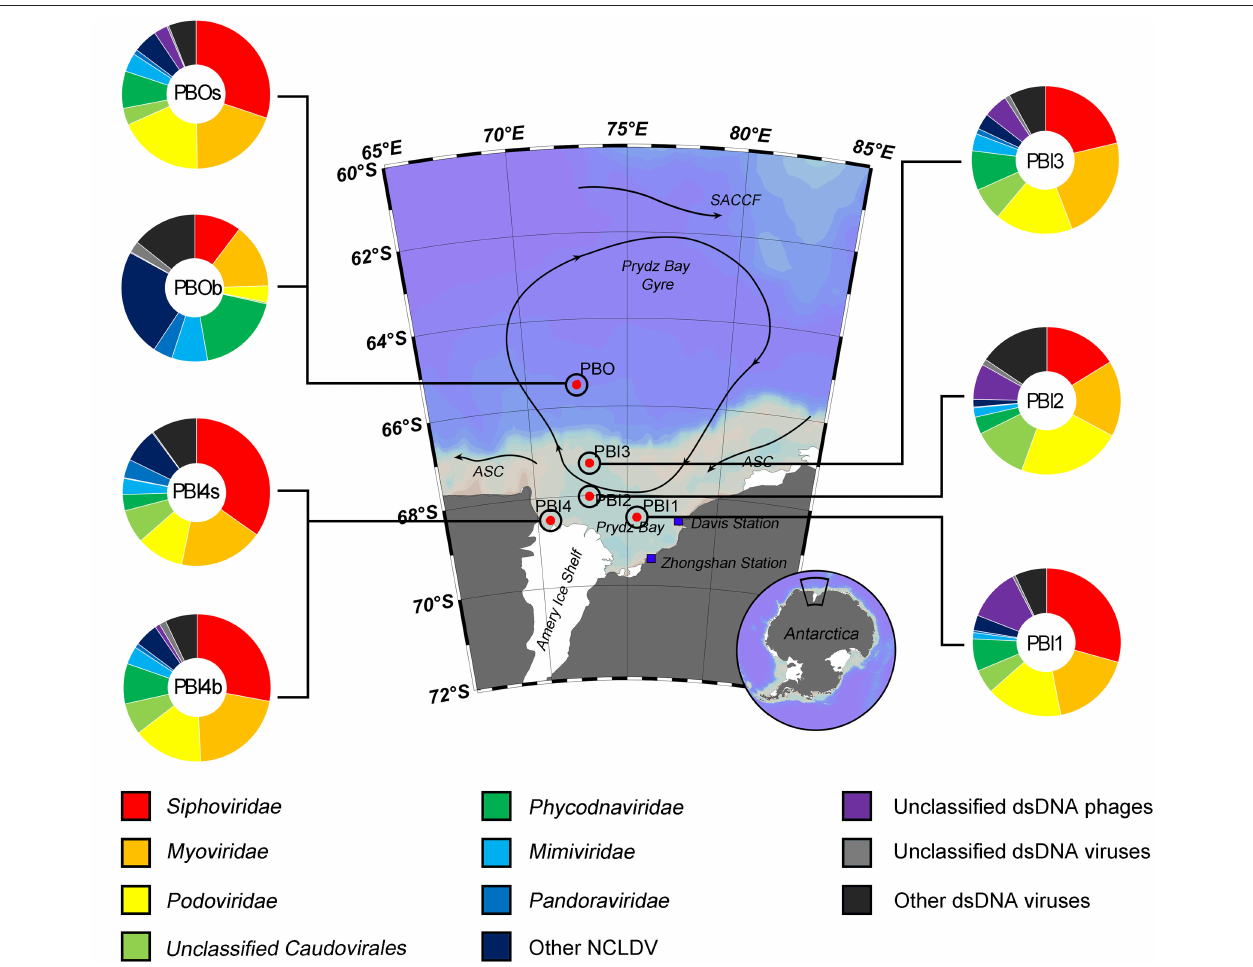
FIGURE 2 | Taxonomic composition of annotated dsDNA viromes in the Prydz Bay, Antarctic. The pie charts show a global representation of dsDNA viral groups for all seven samples from the Prydz Bay. Different colors refer to different viral groups showed in the legend on the bottom.